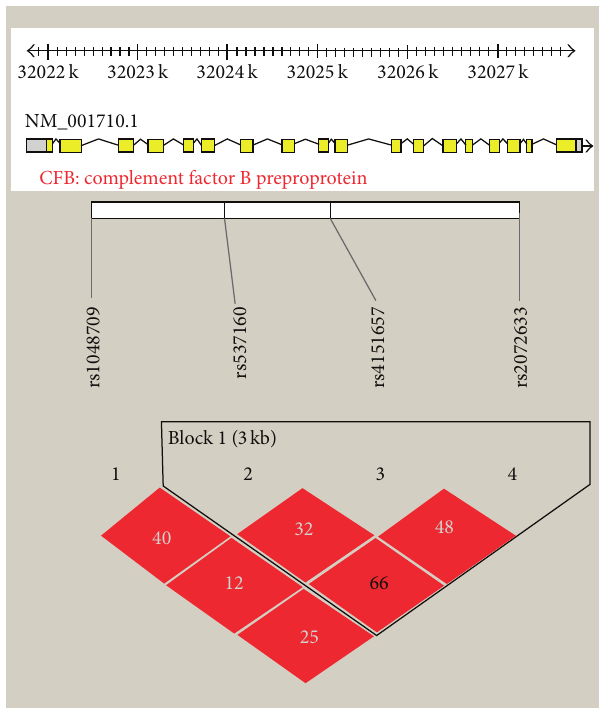
Figure 1: Pairwise LD among three SNPs in CFB gene. Linkage disequilibrium was measured by the 𝐷 󸀠 statistic using the data from all subjects. A 𝐷 󸀠 value of 100 indicates a complete LD between 2 markers, and a 𝐷 󸀠 value of 0 indicates a complete linkage equilibrium. Haplotype version 4.2 software was